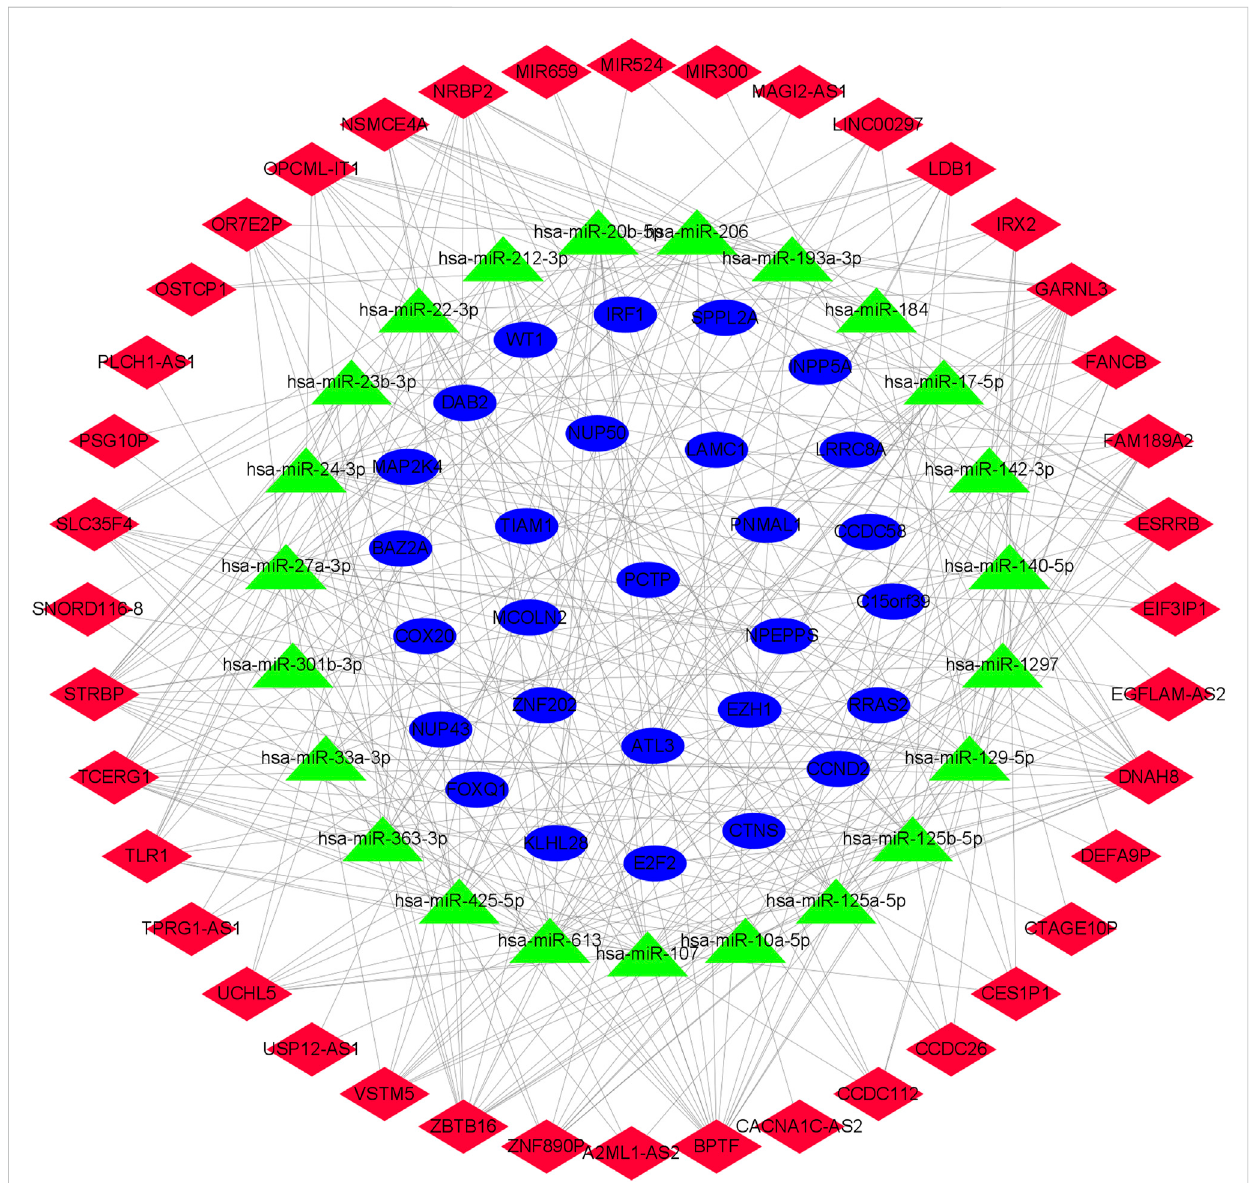
FIGURE 2 Network diagram oflncRNA-miRNA-mRNA. The construction of theceRNA network includes 40 DElncRNA, 23 predicted miRNA and 28 DEmRNA. Blue circles, green triangles and red diamonds represent DEmRNA, miRNA and DElncRNA, respectively. DElncRNA: differentially expressed lncRNA; DEmRNA: differentially expressed mRNA; miRNA: